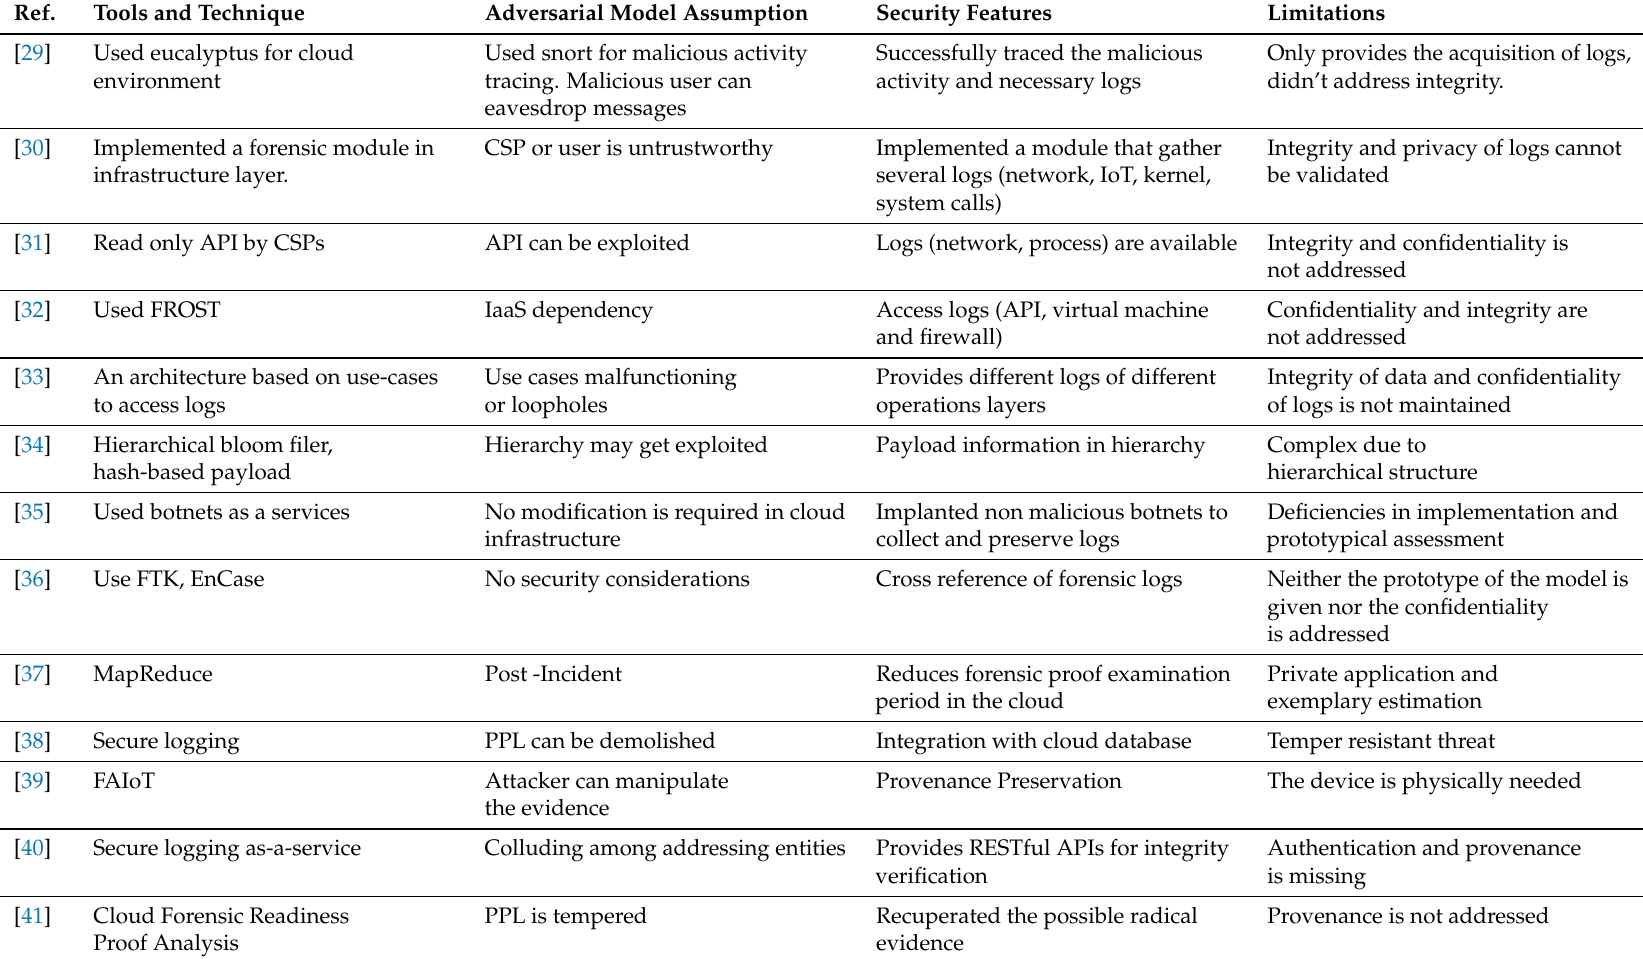
Table 1. Comparison of existing work